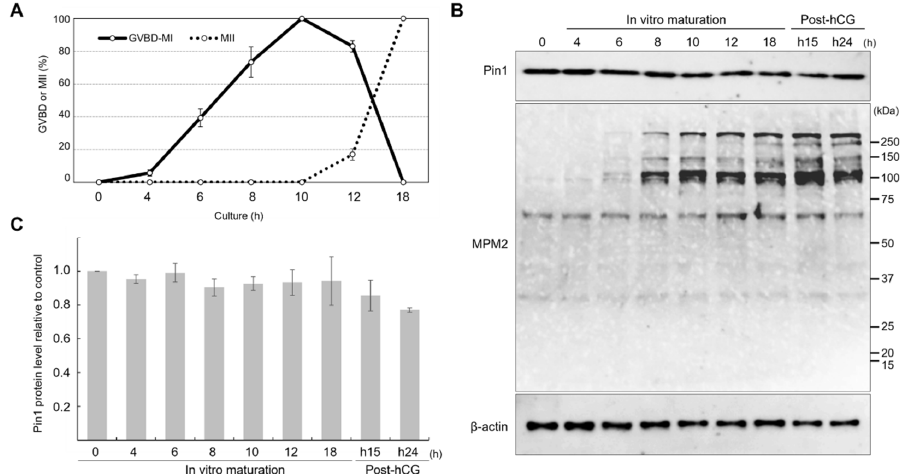
Figure 1. In vitro maturation of oocytes and expression of Pin1 and phosphorylated mitotic proteins detected using anti ‐ MPM2 antibody at different stages of maturation in vitro and in vivo. ( A ) Maturation rates at different times during in vitro maturation of oocytes. Solid and dashed lines indicate the ratios of oocytes in germinal vesicle breakdown ‐ metaphase I (GVBD ‐ MI) and metaphase II (MII), respectively. Data are expressed as means ± SEM for five independent experiments. ( B ) Immunoblot analysis using anti ‐ Pin1 and anti ‐ MPM2 antibodies and extracts of oocytes collected at 0, 4, 6, 8, 10, 12, and 18 h after the start of in vitro culture and in vivo ‐ matured oocytes collected from the oviducts of mice at 15 (h15) and 24 h (h24) after human chorionic gonadotropin injection. Extracts of 50 oocytes were applied to each lane. β‐ actin was used as the loading control. Immunoblot analysis was performed using five sets to confirm reproducibility. ( C ) Protein levels of Pin1. β‐ actin was used as a reference for quantification. The values shown are means ± SEM of three biological replicates. The expression level at 0 h is 1; changes in the expression level of Pin1 over time are shown.